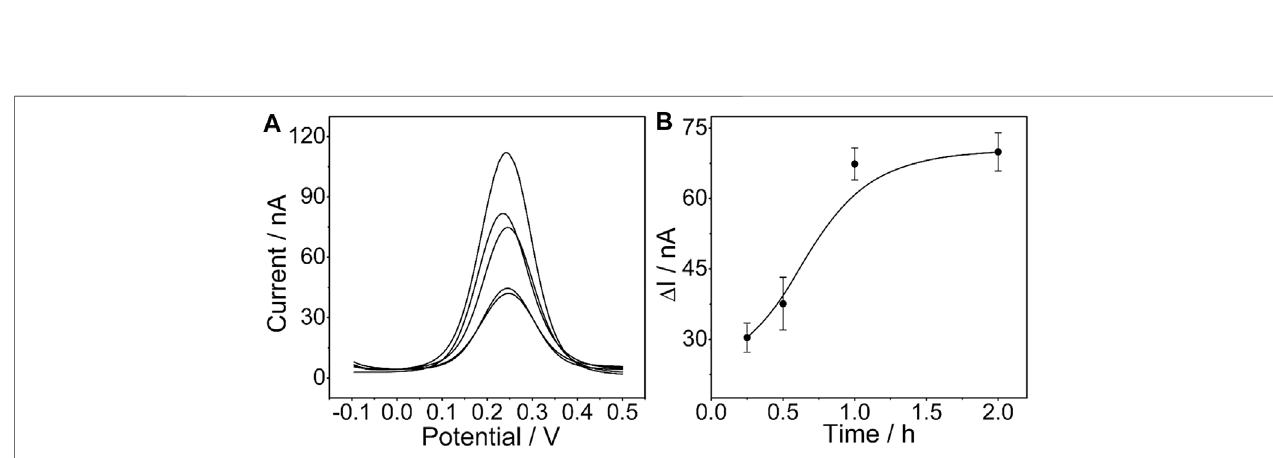
FIGURE 3 | Electrochemical signal and calibration plot of the Pt μ E/Au aptasensors: (A) SWV curve of the Pt μ E/Au electrodes incubated with CEA aptamers, (a) without the CEA aptamer, (b) 10 – 9 M, (c) 10 – 8 M, (d) 10 – 6 M, and (e) 10 – 7 M; (B) SWV calibration plot of Pt μ E/Au incubated with the CEA aptamer range from 10 – 9 M to 10 – 6 M.